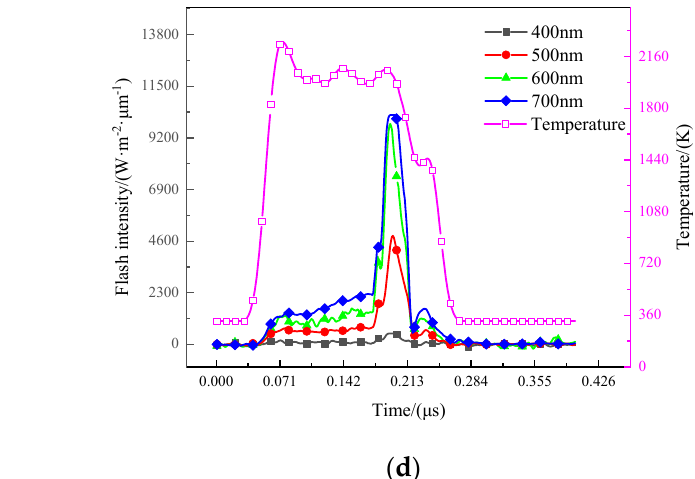
Figure 4. Electrical signal recorded by transient pyrometer and temperature of deflagration flame: ( a ) 62% Hf/38% THV − 1500 m/s ( b ) 88% Hf/12% THV − 1100 m/s ( c ) 26.5% Al/73.5% PTFE − 1880 m/s ( d ) 5.29% Al/80% W/14.71% PTFE − 1150 m/s.